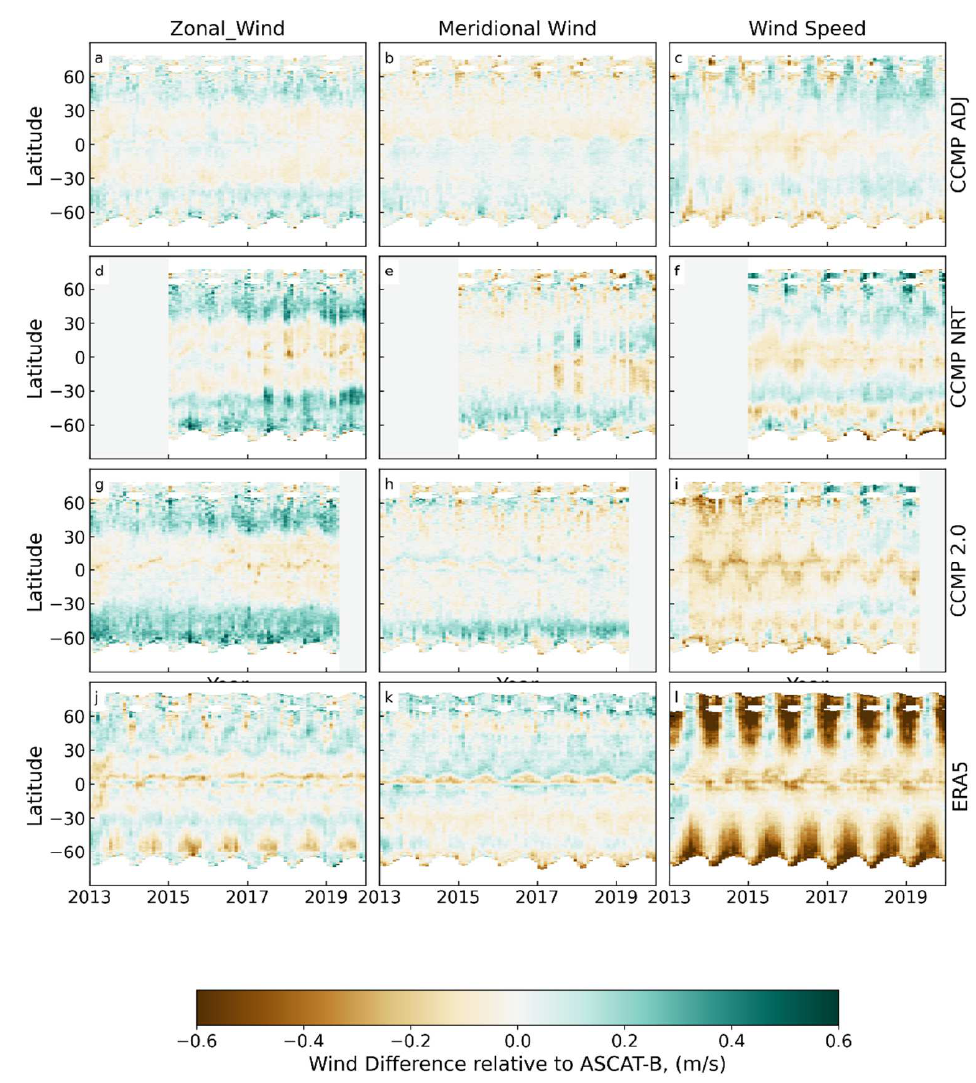
Figure 13. Hovmöller plots of CCMP-ASCAT-B differences for 3 versions of CCMP and ERA5-Oscar. Note that CCMP NRT begins in early 2015, and CCMP 2.0 ends before the end of 2019. ( a – c ) zonal wind, meridional wind and wind speed differecnes for CCMP ADJ—ASCAT-B. ( d – f ) same as ( a – c ) except for CCMPT-NRT—ASCAT-B. ( g – i ) same as ( a – c ), except for CCMP 2.0—ASCAT-B. ( j – l ) same as ( a – c ), except for